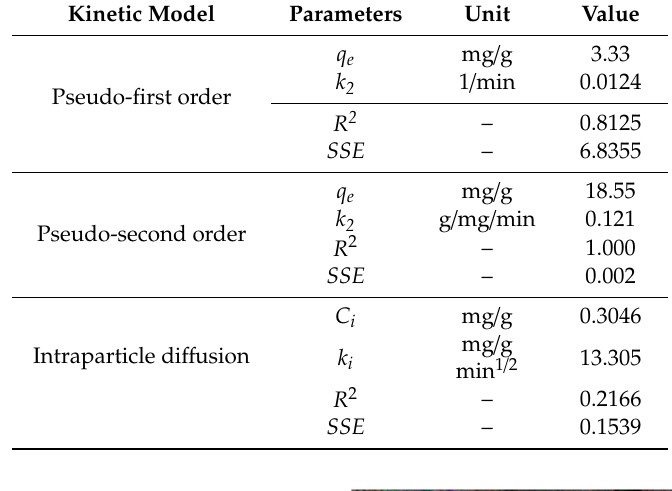
Table 4. Comparison of kinetic parameters of Cd adsorption onto poultry ash (ash dosage = 5 g / L, Cd concentration = 100 mg / L, pH = 5).